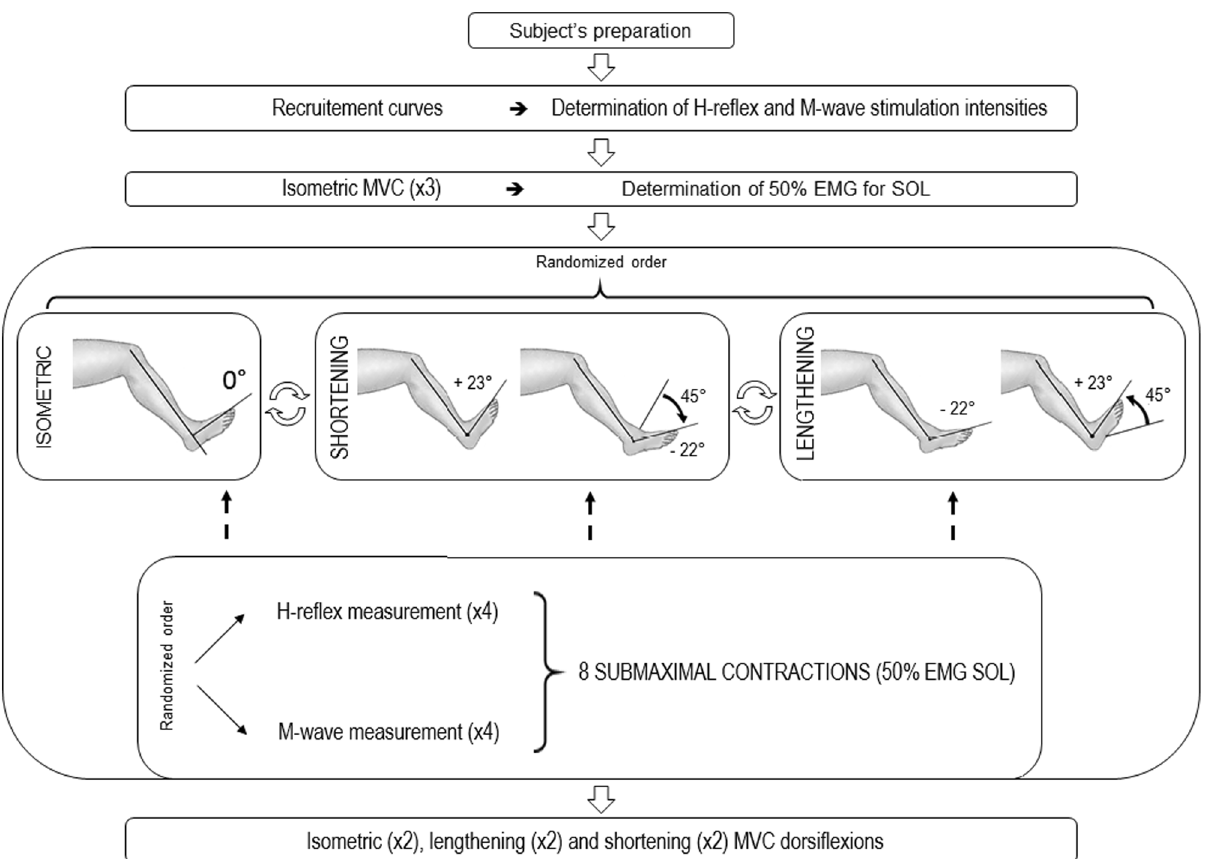
Figure 1. Experimental protocol. MVC maximal voluntary contraction, 50% EMG SOL contraction intensity corresponding to 50% of the EMG obtained during maximal voluntary isometric